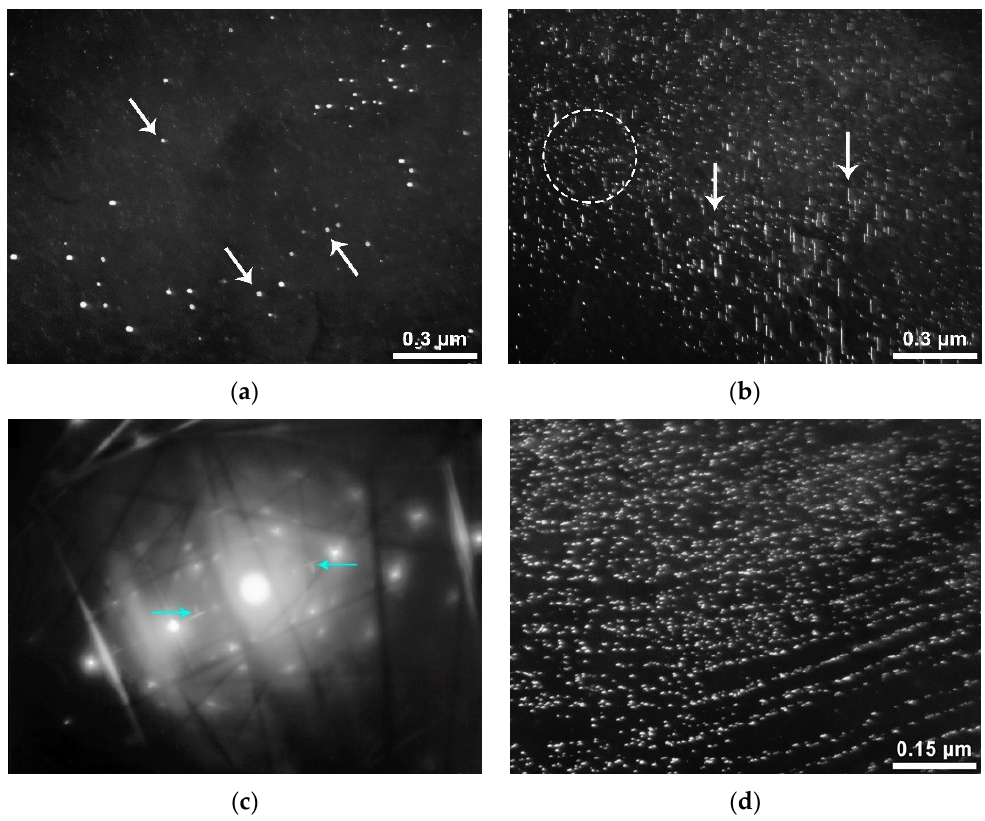
Figure 12. Dark-field image in reflections of nanosized carbonitrides (steel No17): ( a ) Austenitic precipitates (sometimes there are particles closer to a square shape (some of them are indicated by arrows); ( b ) Very narrow ferritic precipitates (about 2 nm), straight and elongated in length up to 60–70 nm (individual up to about 100 nm), circled in the figure and indicated by arrows; ( c ) Microdiffraction pattern (arrows indicate reflexes with two directions of elongation); ( d ) Precipitates of the mixed type.